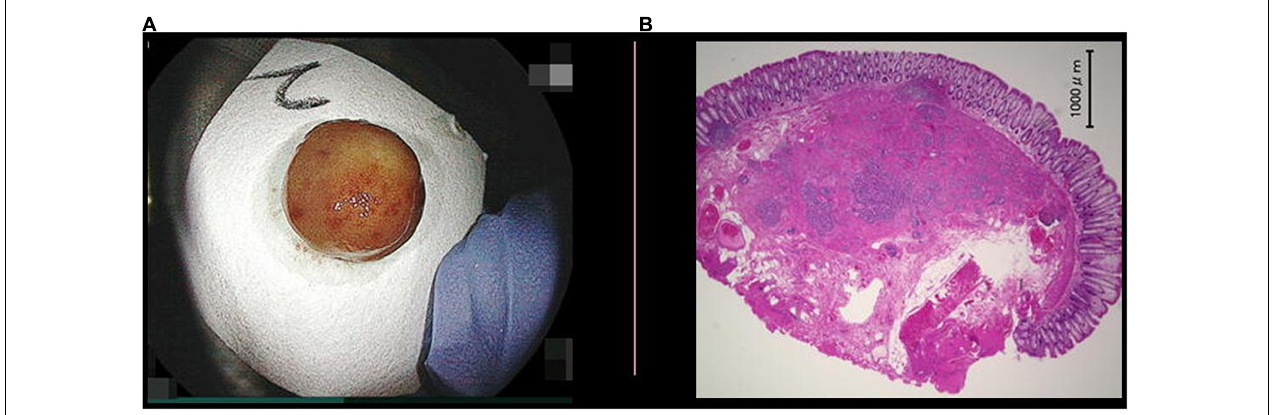
FIGURE 5 | Pathology of a resected neuroendocrine tumor (NET). (A) The specimen of a NET resected with underwater endoscopic mucosal resection, 1 cm in diameter. A NET is identified as a 3 mm yellow submucosal tumor with an obviously negative horizontal margin. The specimen was put on a piece of filter paper with its stump down to be fixed to avoid stump shrinkage. (B) Specimen with hematoxylin and eosin stain showed thick submucosa under the NET and a negative vertical margin. There was no lymph vessel invasion but there was slight venous invasion. The rossete-forming cells observed at low-magnification (hematoxylin and eosin stain, 20 ×